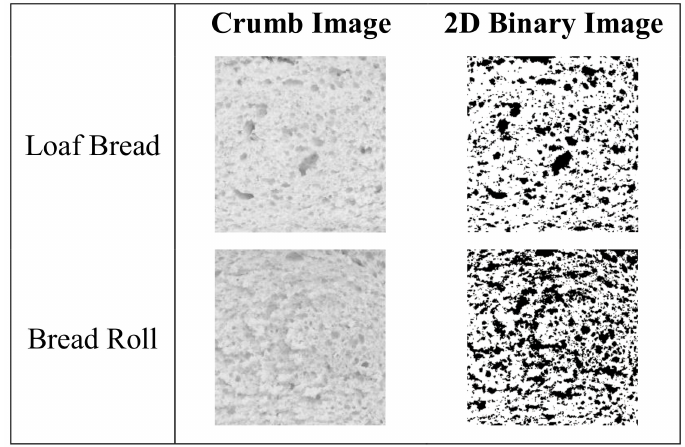
Figure 1. Crumb image of wheat breads shaped to conform to the requirements of the loaf bread and bread